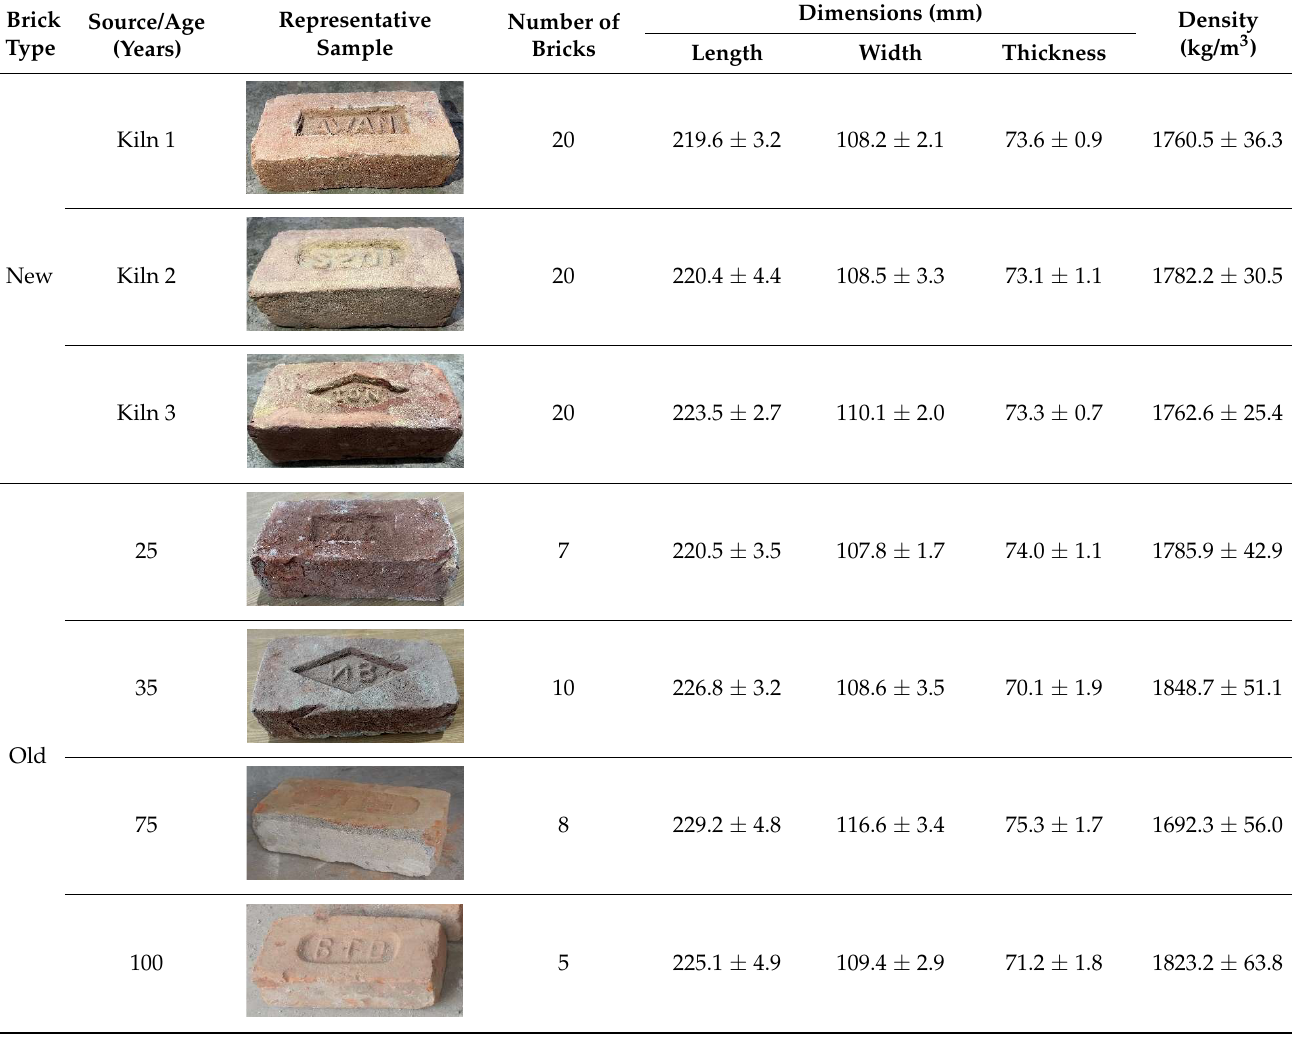
Table 1. Details of test specimen.